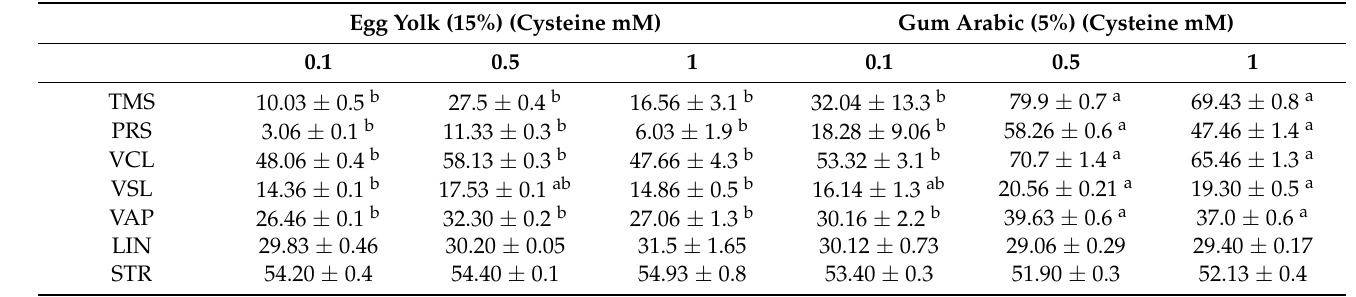
Table 2. Spermatozoa motility and viability parameters (mean ± SEM) in egg yolk and gum arabic extenders supplemented with different concentrations of cysteine (0.1, 0.5 and 1 mM) and stored by deep freezing at − 196 ◦